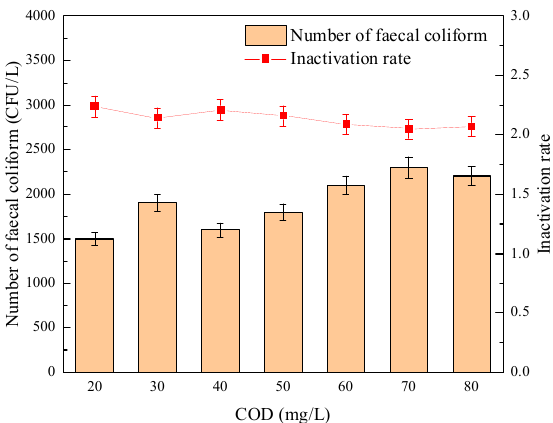
Figure 14. Effect of COD load on the sterilization effect of “Method A”.